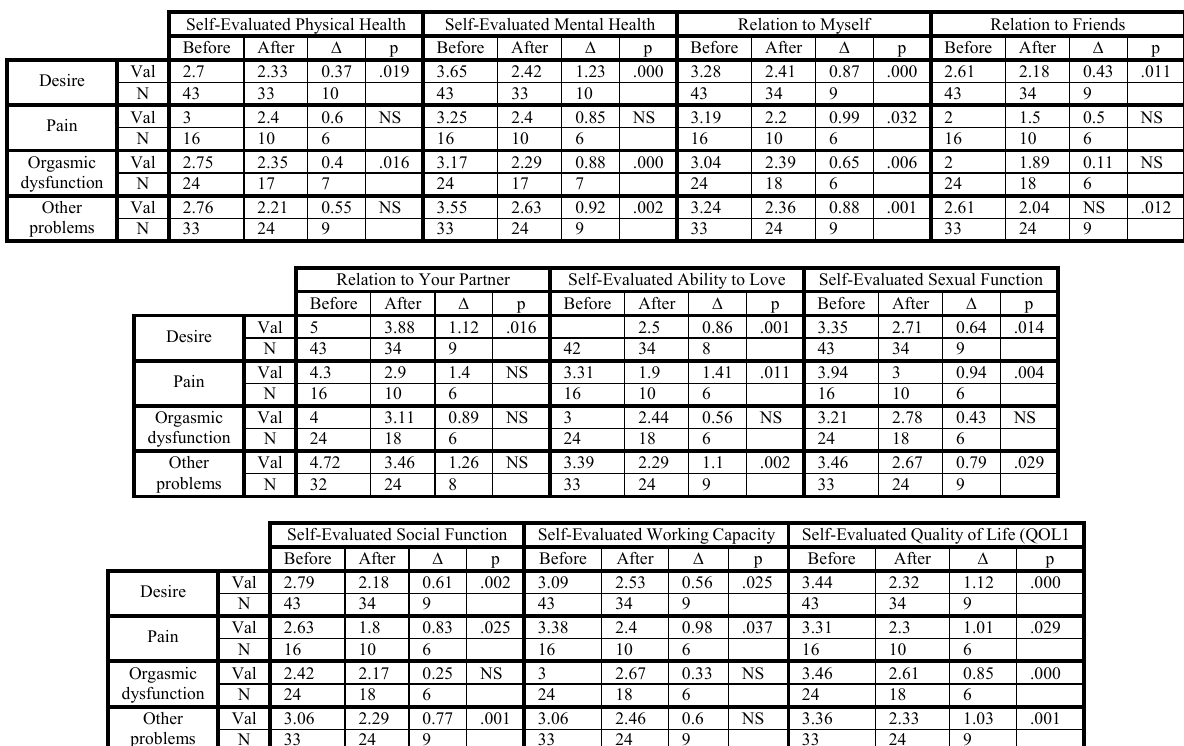
Summary of Patient Identified Sexual